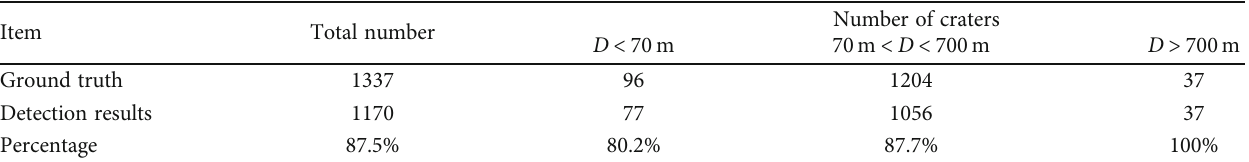
Table 4: Ground truth and detection results.